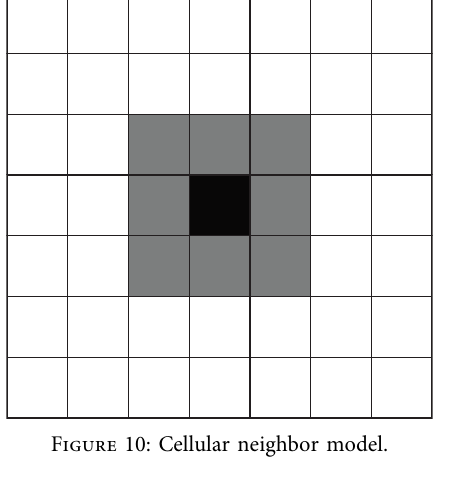
Figure 10: Cellular neighbor model.